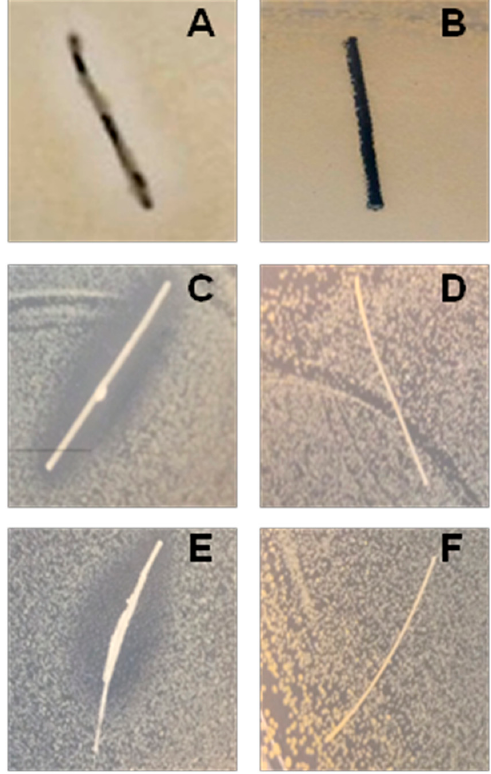
Figure 3. Representative images of the inhibition zones on Mueller-Hinton agar (MHA) plates of the three different surgical sutures treated ( A , C , E ) and untreated ( B , D , F ) with the medical device (MD). The efficacy of the MD versus S. aureus is demonstrated by the presence of an inhibition zone around the treated sutures. Similar results have been obtained versus E. faecalis.